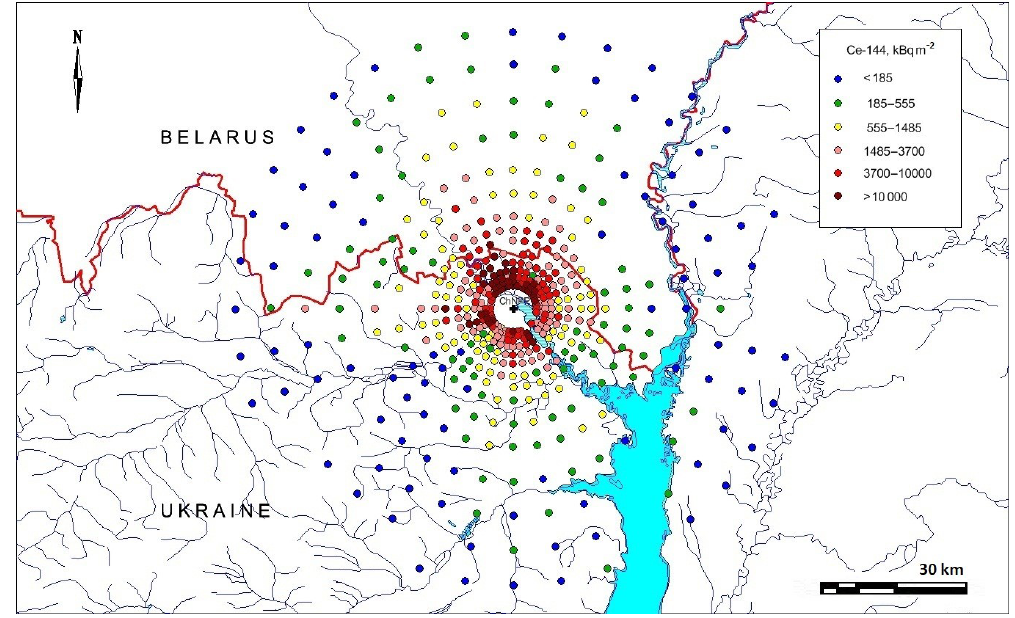
Figure 3. The fallout density of 144 Ce (kBqm − 2 ) within the 60km zone around the ChNPP decay corrected to 6 May 1986.